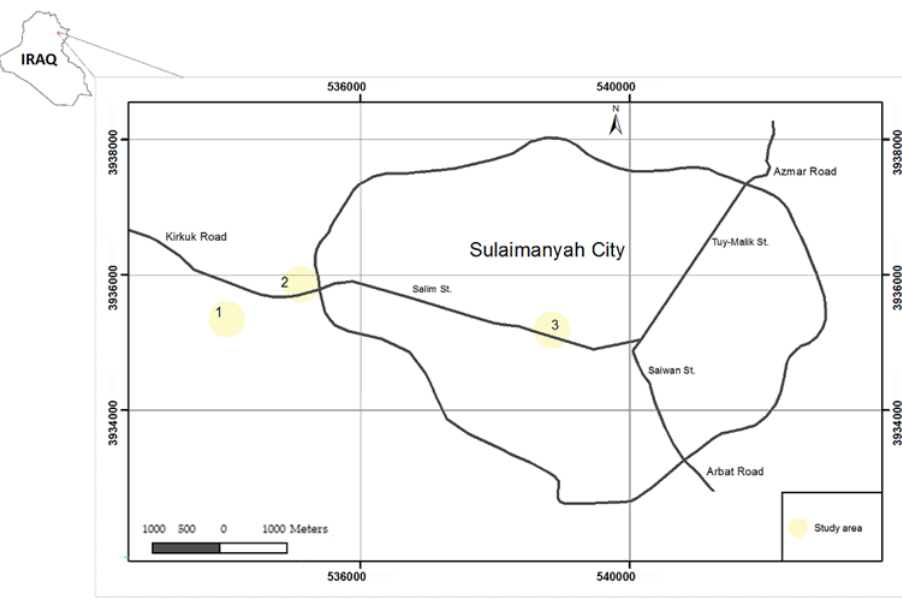
Figure 2. Location of the study area and the sampling locations.